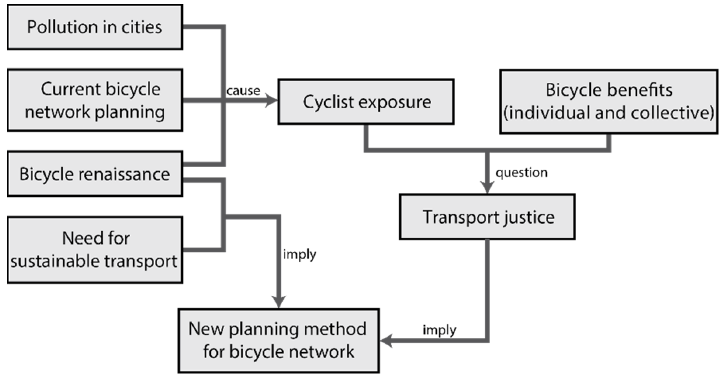
Figure 2. The situation of bicycles in cities.